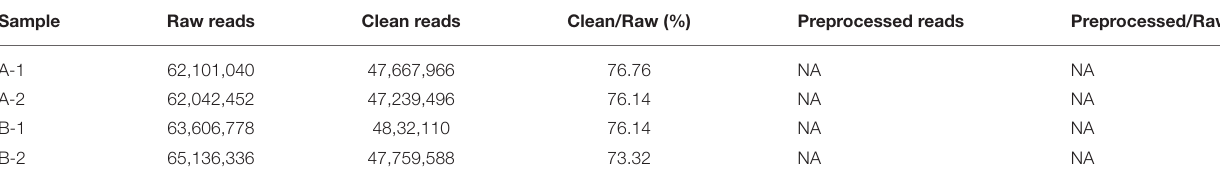
TABLE 1 | Summary of sequencing data for each sample.